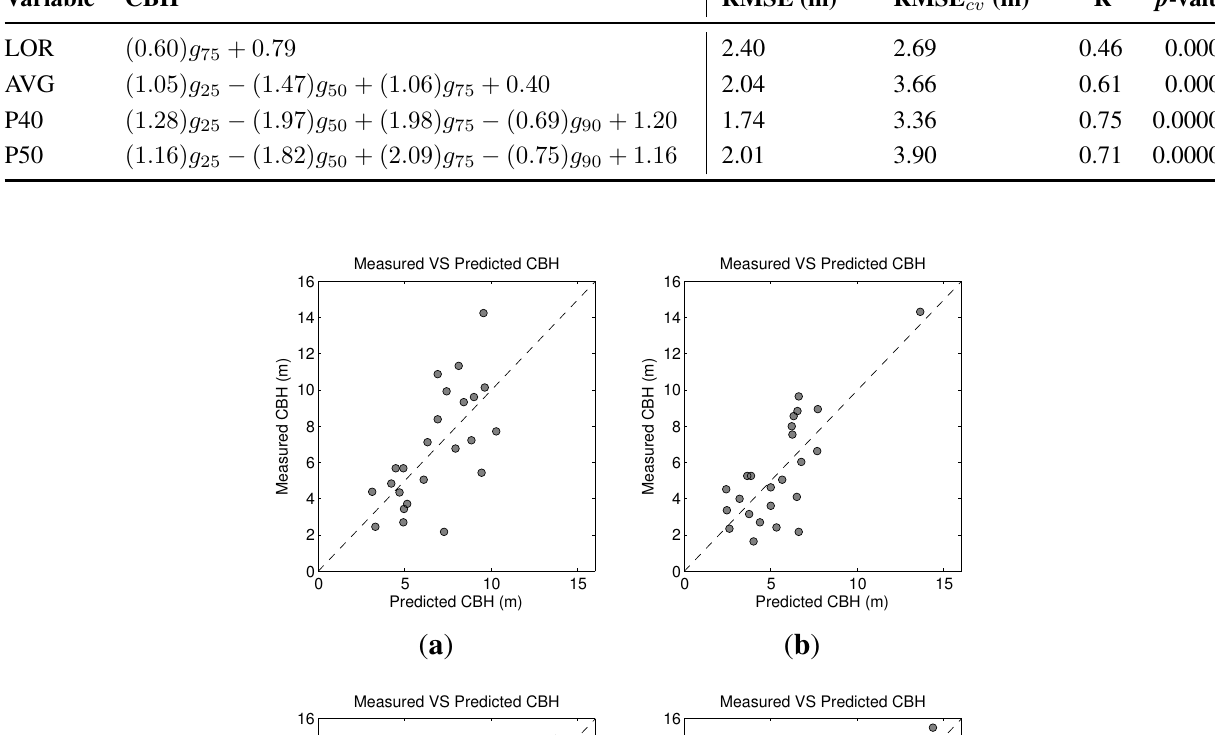
Table 2. Regression models obtained using different dependent variables against the proposed LiDAR metrics. LOR, Lorey’s mean; AVG, arithmetic mean; P40, 40th percentile. Variable